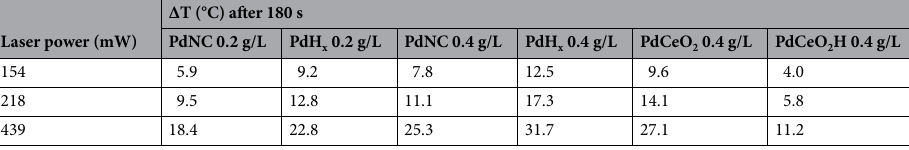
Table 2. Temperature variations of nanofluids of PdNC, PdCeO 2 and their hydrogenated forms.